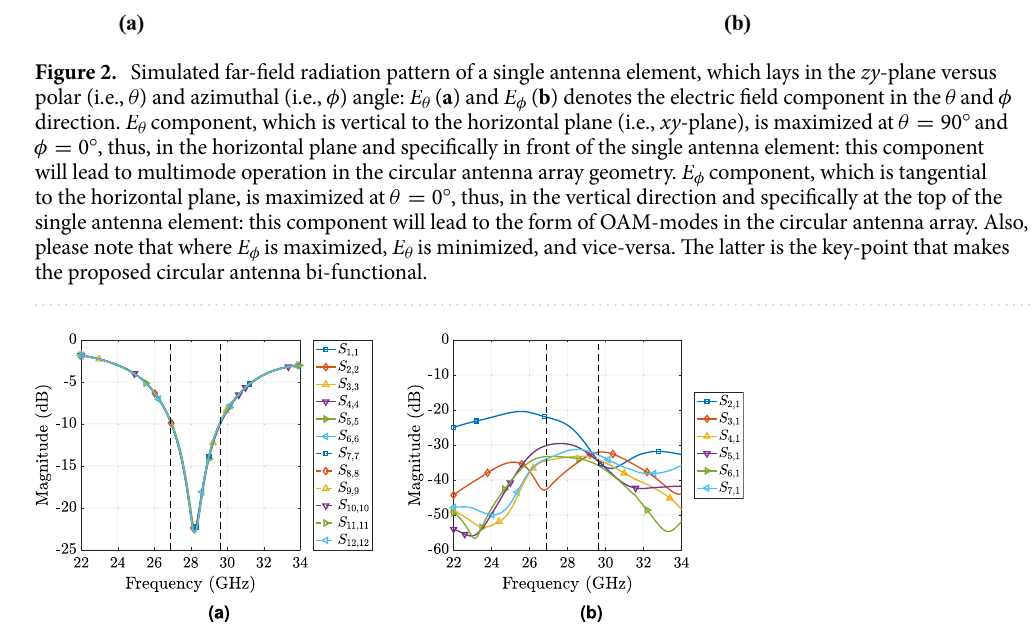
Figure 3. Simulated reflection coefficients relative to 50 (cid:31) ( a ) and mutual coupling ( b ) of the 12-element circular antenna array: analysis took place in CST Studio Suite and lumped ports of 50 (cid:31) were used to simultaneously feed all the antenna ports. For the mutual coupling analysis only 7 out of 12 elements were tested due to the cylindrical antenna array